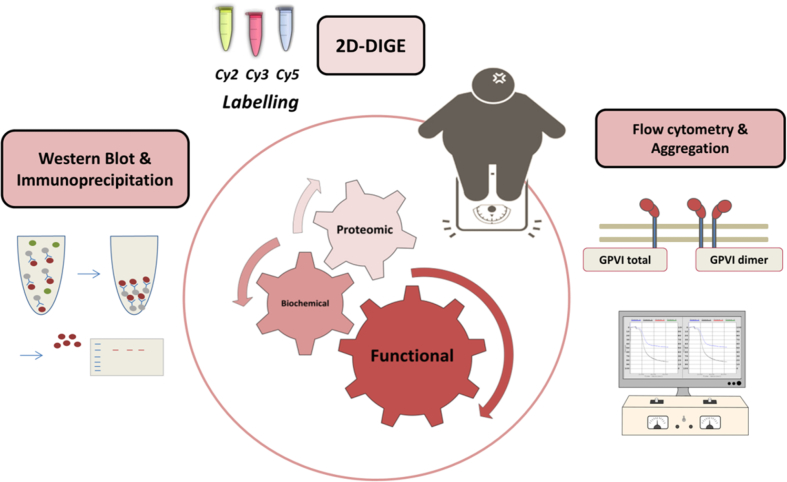
Schematic workflow of the study.